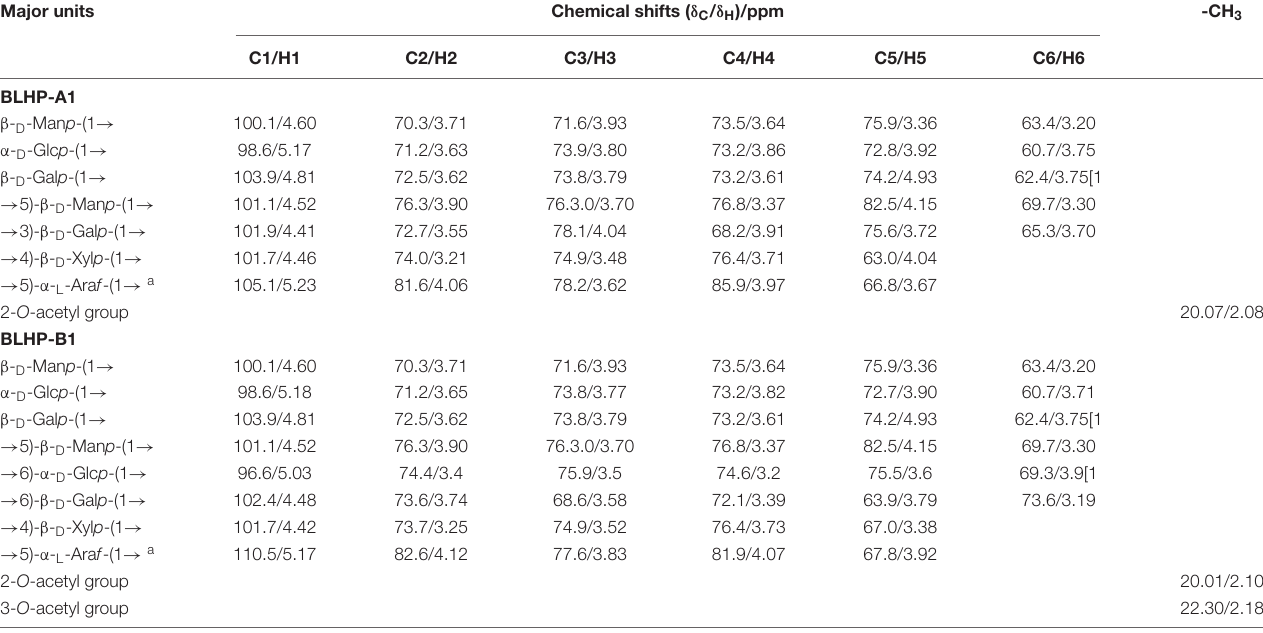
TABLE 1 | The signal chemical shifts (ppm) of the major structures detected by NMR spectra of BLHP-A1 and BLHP-B1 samples. Major